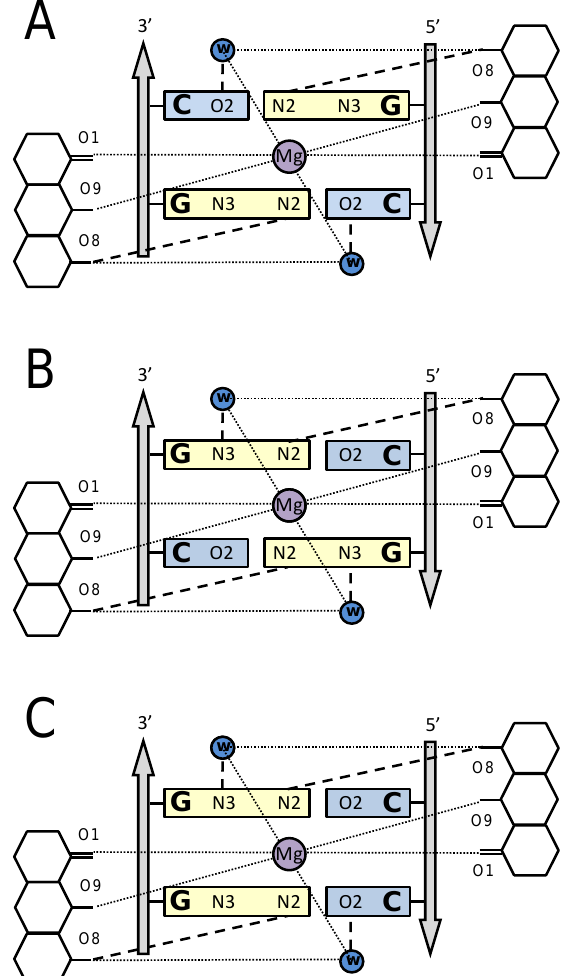
Figure 5. Schematic interaction of the OA aglycon and the central dinucleotide GC ( A ), CG ( B ) and GG (C) of the DNA binding site. ( A ) The network of hydrogen bonds between the minor groove edges of G-C base pairs and OA is depicted according to the X-ray structure (PDB ID: 1VAQ) of the Chro complex with self-complementary oligonucleotide 5’-TTGGCCAA containing central GC [12] . ( B , C ) The proposed models of hydrogen bonding in complexes of OA with binding sites containing central dinucleotides 5’-CG and 5’-GG.